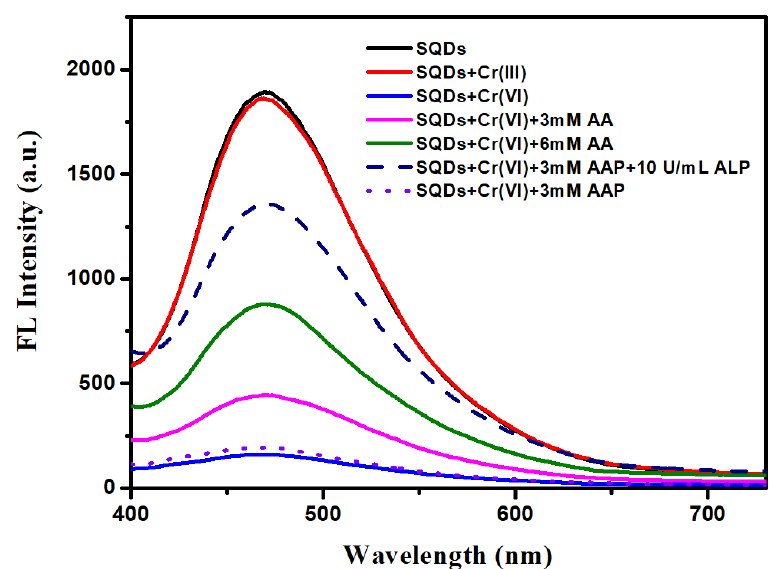
Figure 2. Feasibility analysis of the assay for ALP detection.